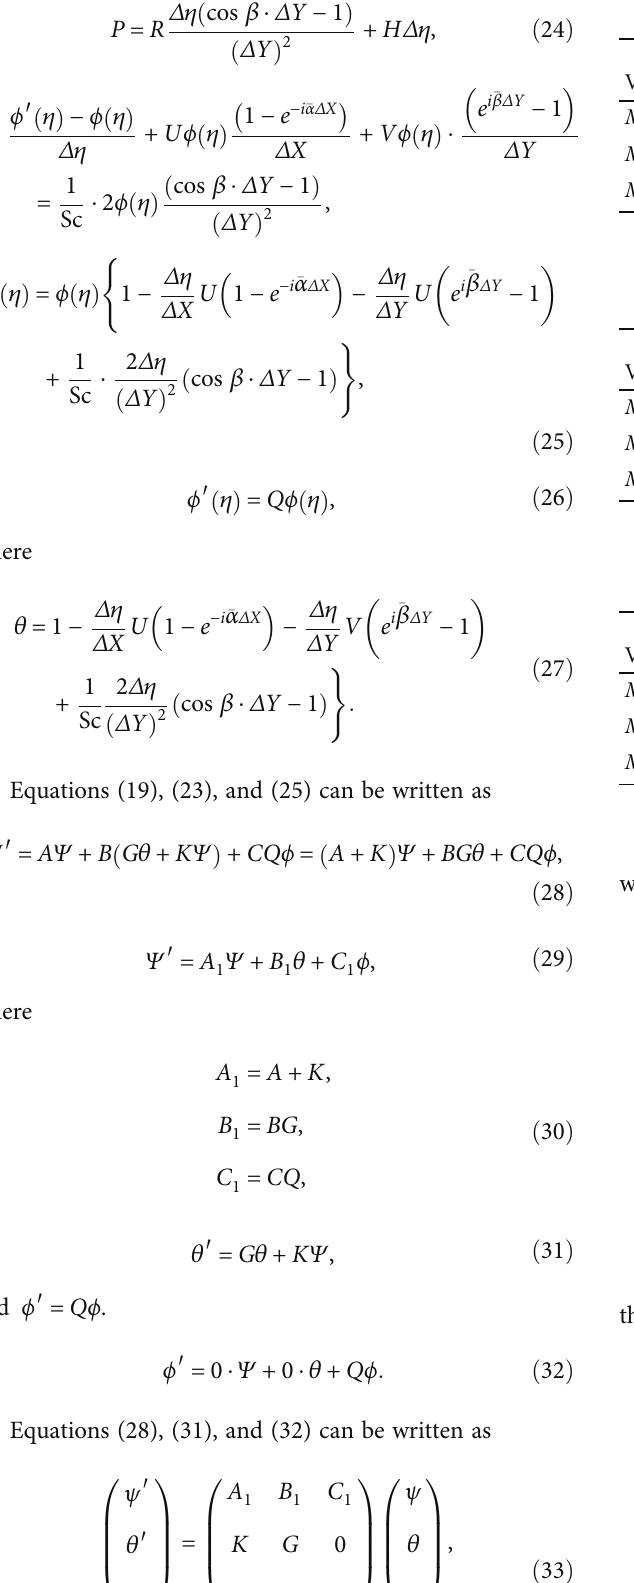
Table 3: Variability of curve when Y = 1 in Figure 7(a).